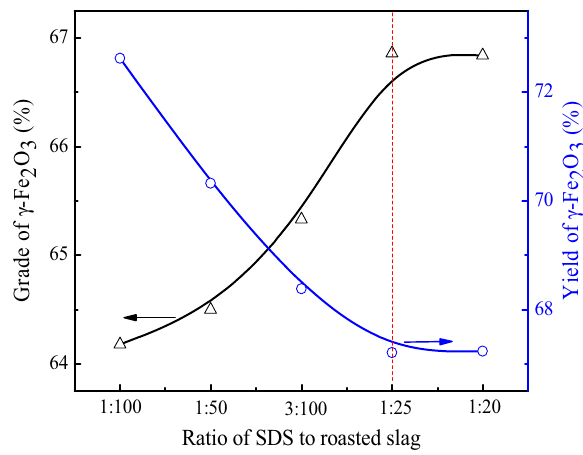
Figure 7: E ff ect of the ratio of SDS to roasted slag on γ - Fe 2 O 3 recovery.